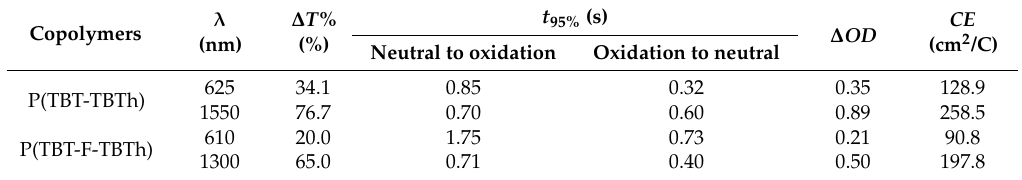
Table 2. Δ T%, t 95% and CE of P(TBT-TBTh) and P(TBT-F-TBTh) at their corresponding wavelengths.